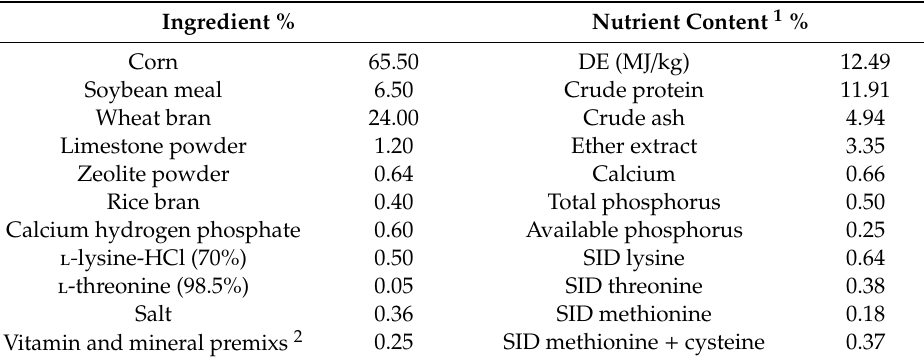
Table 1. Composition and nutrient levels of the basal diet (air-dry